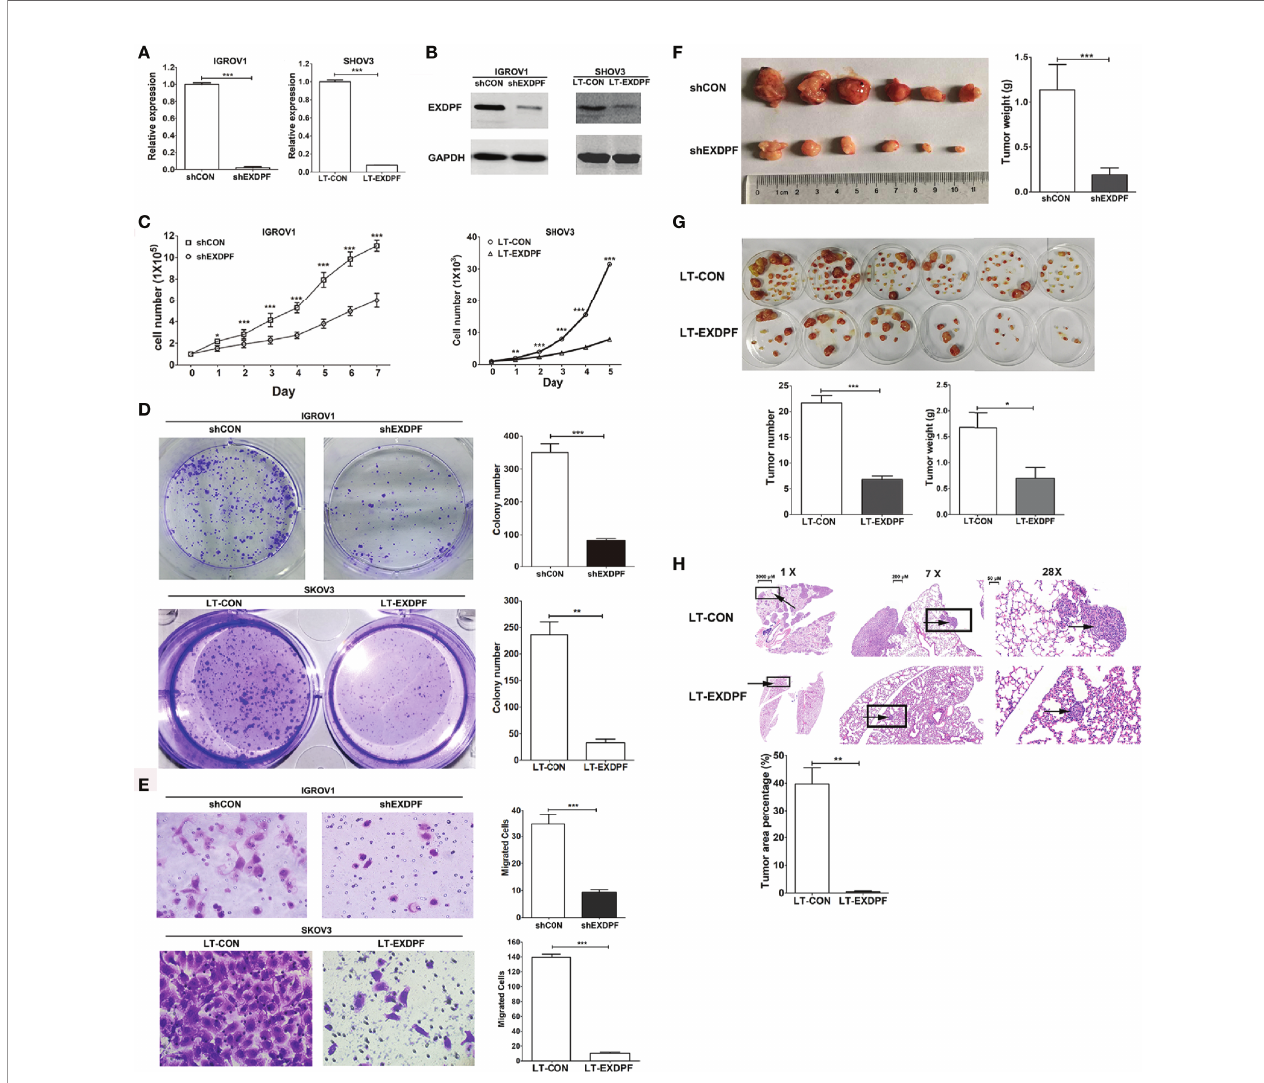
FIGURE 2 | Knock-down of EXDPF inhibits ovarian cancer tumorigenesis. (A) EXDPF mRNA expression levels in IGROV1 (left panel) and SKOV3 (right panel) cells were knock-down by shRNA plasmid (shEXDPF) and lentivirus expressing shRNA targeting EXDPF (LT-EXDPF), respectively. IGROV1 transfected with control plasmid (shCON) and SKOV3 infected with control lentivirus (LT-CON) served as negative controls. (B) Decreased EXDPF protein levels caused by RNA interference in IGROV1 (left panel) and SKOV3 (right panel) cells were detected by Western Blotting. (C) EXDPF knock-down and control IGROV1 (left panel) or SKOV3 (right panel) cells were cultured and counted for successive 5 to 7 days. Cell numbers were compared between EXDPF knock-down and control groups at each day. (D) One thousand of IGROV1 and SKOV3 cells, both EXDPF normal expression control (shCON and LT-CON, respectively) or knock-down (shEXDPF and LT- EXDPF, respectively) cells, were seeded into 6 well plates and cultured for 10 days for colony counting. Representative images of colonies in a well of 6 well plates were shown in the left panels, and statistical data were shown in the right panels. (E) For detection of the ability of cell migration, 1 × 10 5 EXDPF knock-down or control cells as elucidated in panel (D) were seeded into a well of transwells and plated into 24 well plates. Transferred cells were counted after a culture duration of 18 h. The left panels show the representative images and the right panels show the statistical data compared between EXDPF knock-down and control groups. Images were token by a microscope under 200-fold magnitude. (F) BALB/c null nude mice were subcutaneously inoculated with 1 × 10 6 EXDPF knock-down (shEXDPF group) or control (shCON group) IGROV1 cells. Mice were sacri fi ced 4 weeks later and tumors were collected and weighed. Tumor images were shown in left panel. Statistical data of tumor weights were shown in the right panel. (G) EXDPF knock-down (LT-EXDPF group) or control (LT-CON group) SKOV3 cells were inoculated intraperitoneally into nude mice at the amount of 1 × 10 6 . Four weeks later, mice were sacri fi ced and tumor nodes from the abdominal organs or tissues of each mouse were removed to a 6 cm dish, photographed and weighed. Tumor images were shown in the upper panel while statistical analysis of tumor numbers and tumor weights were shown in the lower panels. (H) 1 × 10 6 EXDPF knock-down (LT-EXDPF group) or control (LT-CON group) SKOV3 cells were injected into nude mice through tail vein. Six weeks later, mice were sacri fi ced and lungs were derived, fi xed with 4% paraformaldehyde and sliced into 5 m m sections followed by HE staining. The upper left panel is the scan images of whole lungs. The upper middle and right panels are a 7- and 28-fold magnitude zoomed images of the rectangle marked areas in the left and middle panels, respectively. Arrows within each sample marked the same tumor. The tumor burden was de fi ned as the percentage of tumor areas to the whole lung areas. Statistical analysis of tumor burdens between mice inoculated with EXDPF knock-down and control SKOV3 cells was shown in the lower panel. Statistic data are presented as mean ± SD. * p < 0.05; ** p < 0.01; *** p <